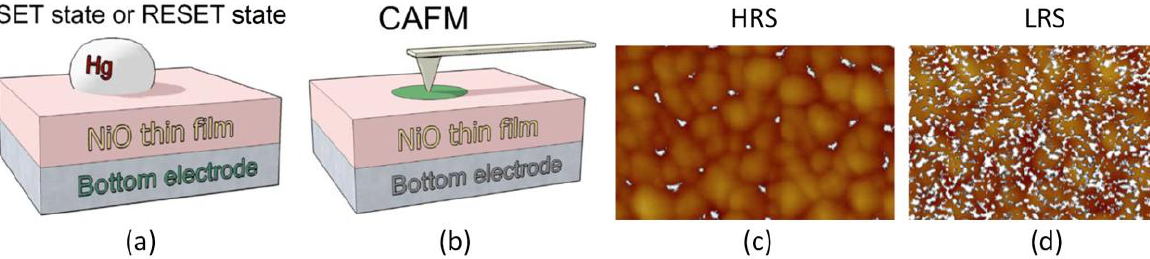
Figure 2. ( a ) Schematic of a Hg/NiO/Pt nanocapacitor. In this experiment the HRS and LRS are induced at the device level; ( b ) After that, the top electrode is etched and the stressed area is analyzed with the tip of the CAFM applying a low voltage (read-like scan); ( c , d ) show the topographic and superimposed current map of two capacitors, one in HRS and the other in LRS (respectively). The width of the current maps is 500 nm.